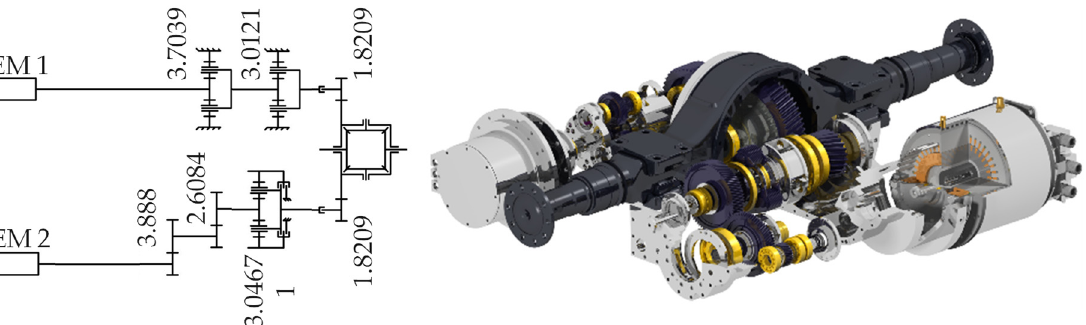
Figure 4. Prototypical realised gearbox topology including ratios and CAD rendering of the proto- typical electric drive axle